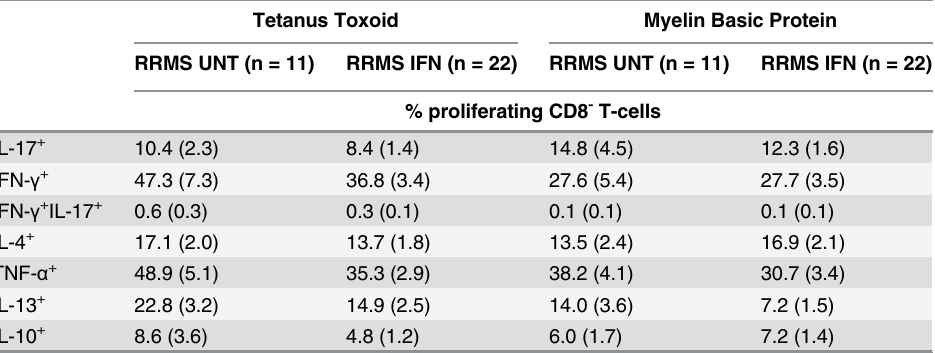
Table 3. Phenotype of tetanus toxoid (TT)- and myelin basic protein (MBP)-reactive CD3 + CD8 - T-cells, from untreated (UNT) and interferon (IFN)- β -treated patients with relapsing-remitting multiple sclerosis